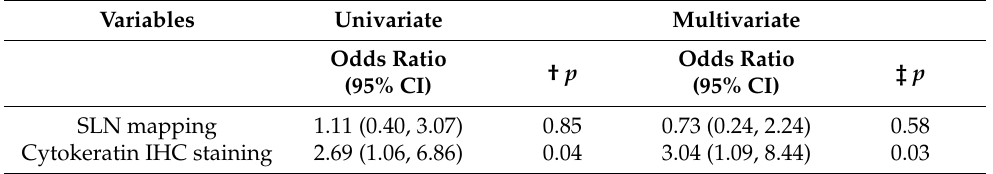
Table 4. Predictors of lymph node